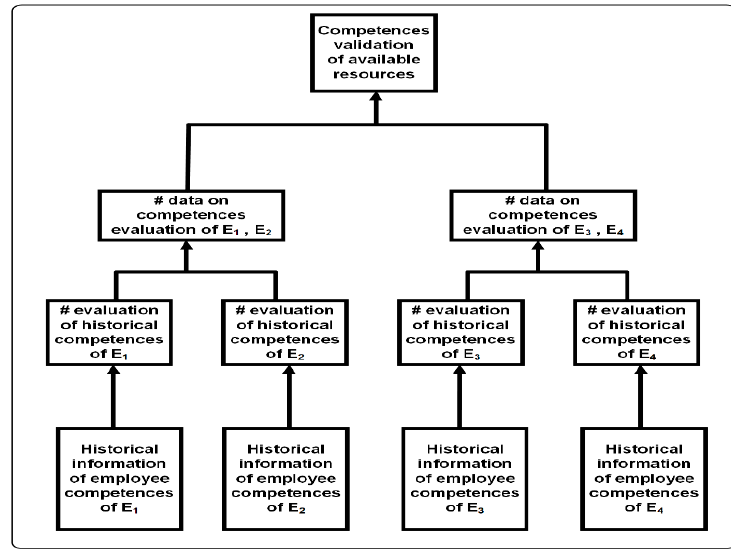
Figure 5. Merkle tree for employee competency assessment.